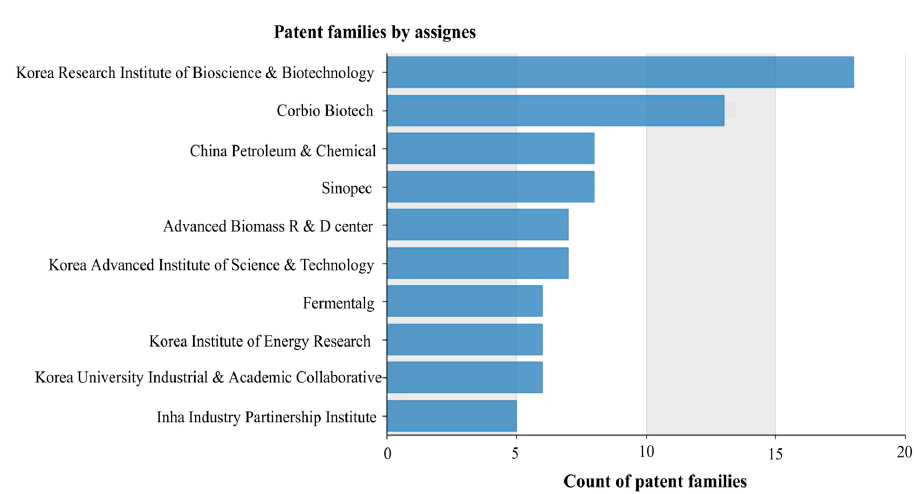
Figure 9. Top ten applicants for documents in relation to microalgae lipids.